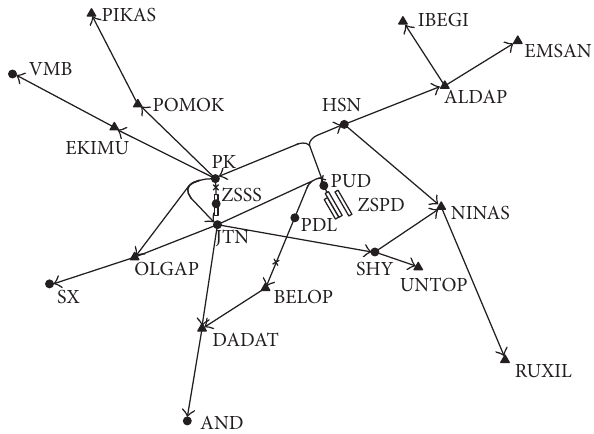
Figure 14: Departing air traffic model of the Shanghai terminal control area.